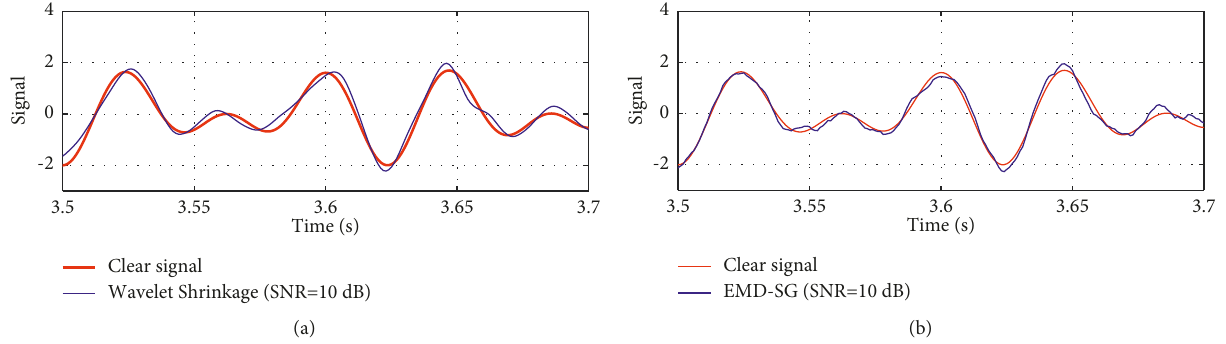
Figure 3: Noise elimination of non-stationary signal using traditional methods: (a) Wavelet shrinkage method; (b) EMD-SG method.